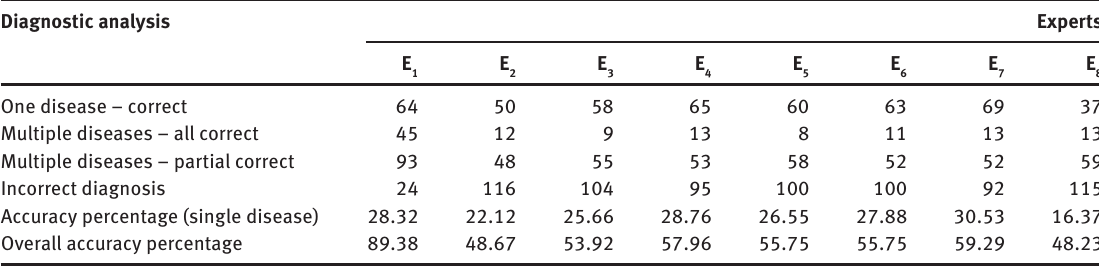
Table 8: Diagnosis Analysis for Eight Experts after Applying “History” Rule Base (Eight Experts, 226